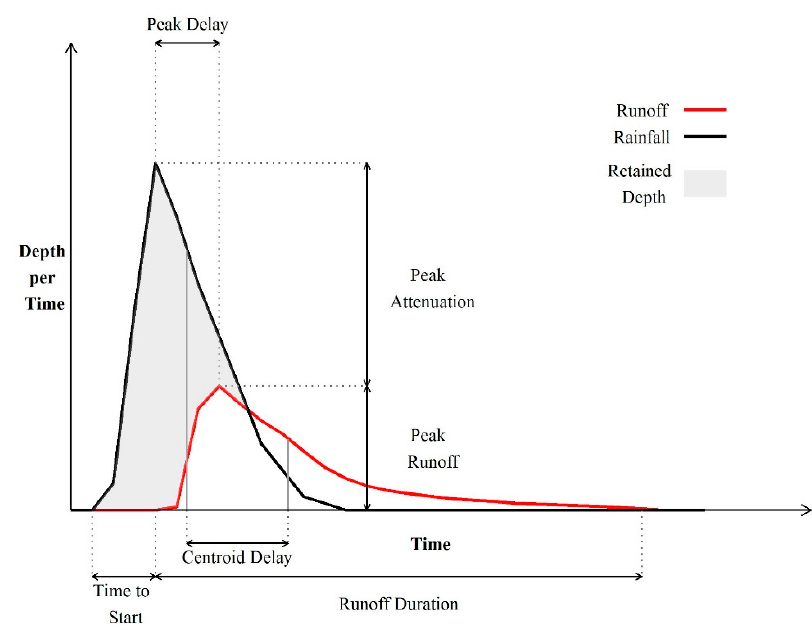
Figure 2. Retention and detention metrics.